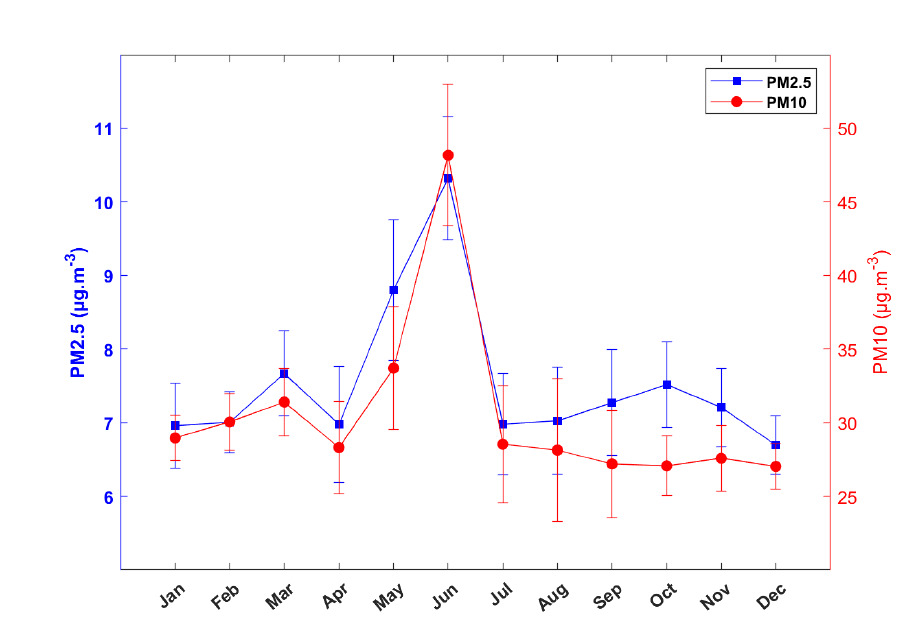
Figure 8. Monthly average of PM 2.5 and PM 10 concentrations in PR between 2000 and 2020. Standard deviations are illustrated by the whiskers.